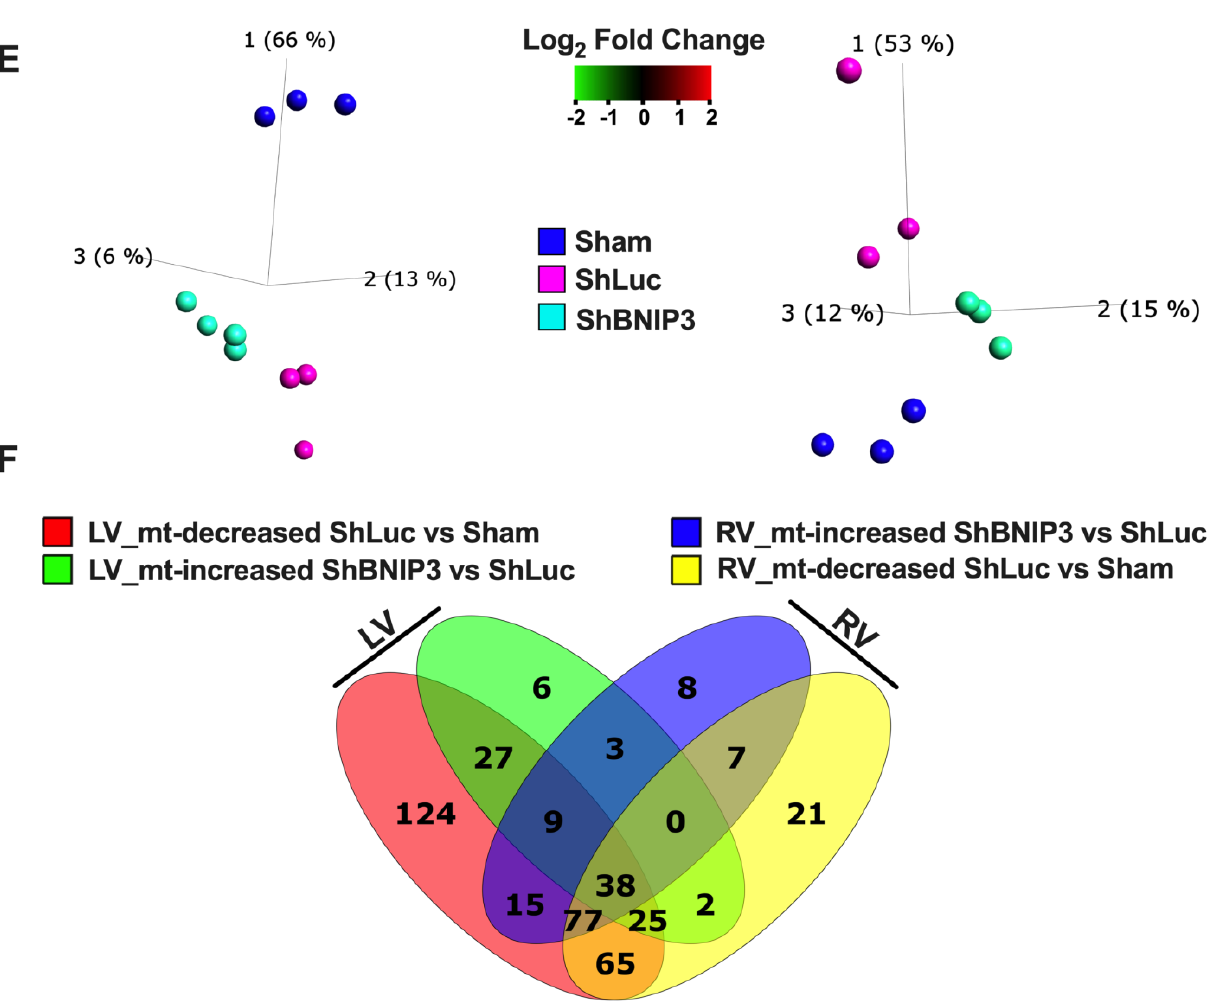
Figure 1. Visualization of the differentially expressed proteins in ShBNIP3 vs. ShLuc groups in the LV and RV myocardium proteomic datasets. ( A , B ). Heat maps and PCA plots show the relative log 2 -fold expression and the variance in biological samples, respectively, in Sham and HFrEF, and ShLuc and ShBNIP3 groups of the differentially expressed proteins in ShBNIP3 vs. ShLuc in LV (left) and RV (right) shotgun proteomic datasets. ( C ). Venn diagrams show the number of proteins that were differentially downregulated (red) or upregulated (yellow) in ShLuc vs. Sham in LV (left) and RV (right) shotgun proteomic datasets, and how many of these were mitochondrial (mt)-proteins (intersection of blue with red or yellow diagrams, respectively). They also show the number of proteins that were differentially upregulated in ShBNIP3 vs. ShLuc (green), and how many of these were mt-proteins (intersection of blue with green diagrams). ( D , E ). Similar to A and B, with the exception that the heat maps and PCA plots represent the differentially expressed mt-proteins in ShBNIP3 vs. ShLuc groups. ( F ). Venn diagrams show the number of mt-proteins that were differentially downregulated in ShLuc vs. Sham (red and yellow), and those that were differentially upregulated in ShBNIP3 vs. ShLuc (green and blue) in LV and RV shotgun proteomic datasets, respectively. Note: the stand-alone column in the presented heat maps shows the hierarchical clustering of variables and the average log 2 -fold change in Sham biological samples. This is applicable for all the subsequently presented heat